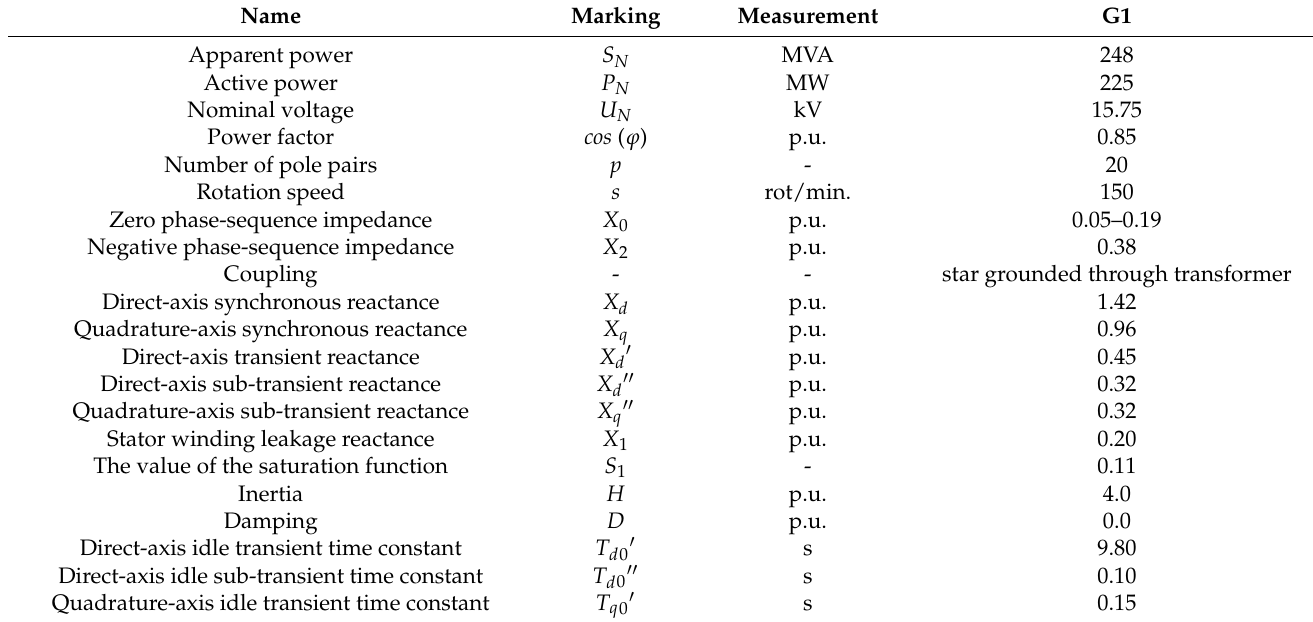
Table 1. Hydro-generator G1’s main parameters.